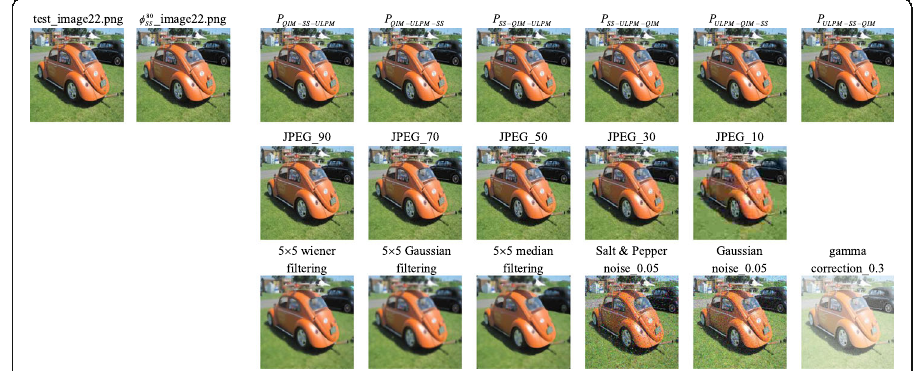
Fig. 5 Processed images of “ ϕ 80 _image22.png ” applied by our method, JPEG compression, wiener filtering, SS